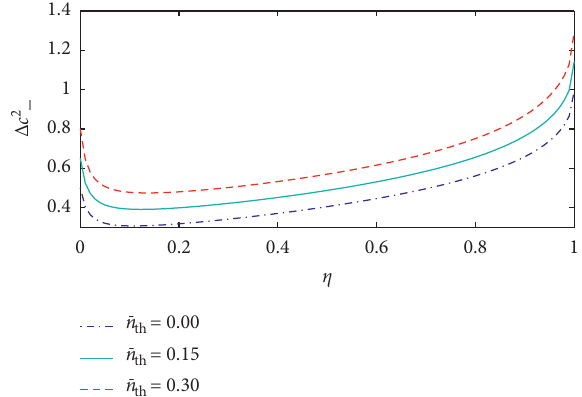
Figure 2: Plots of the quadrature variance (equation (25)) versus η for A � 100, κ � 0 . 8, ε � 0 . 399 and for different values of n th .